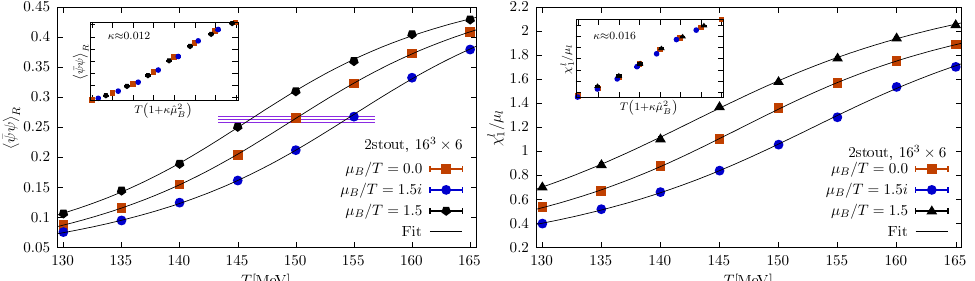
Figure 2: The renormalized chiral condensate (left) and the light quark number-to- / T = 1.5,0 light quark chemical potential ratio (right) as a function of T at fixed µ B and 1.5 i on 2stout mproved lattices at N τ = 6. The insets show a rescaling of the (cid:128) (cid:0) µ (cid:1) 2 (cid:138) B temperature axis by T → T 1 + κ , which approximately collapses the curves T onto each other if κ ≈ 0.012 and 0.016 are chosen for the chiral condensate and the quark number-to-chemical potential ratio, respectively.